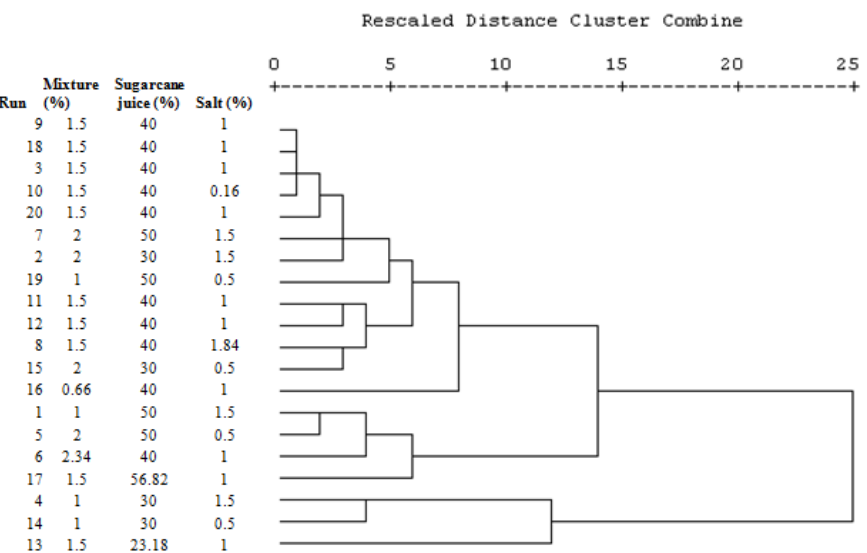
Figure Figure 2. Cluster analysis of the different variables selected for the development of spiced cucumber beverage.